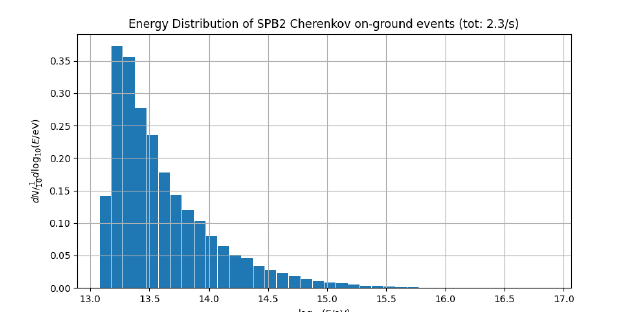
Figure 13: Simulated event rate of downward going cos- mic rays for the CT of EUSO-SPB. In this configura- tion, the CT points 60 ◦ in elevation. During field testing, the CT’s orientation was varied between perfectly vertical (90 ◦ ) and 60 ◦ .